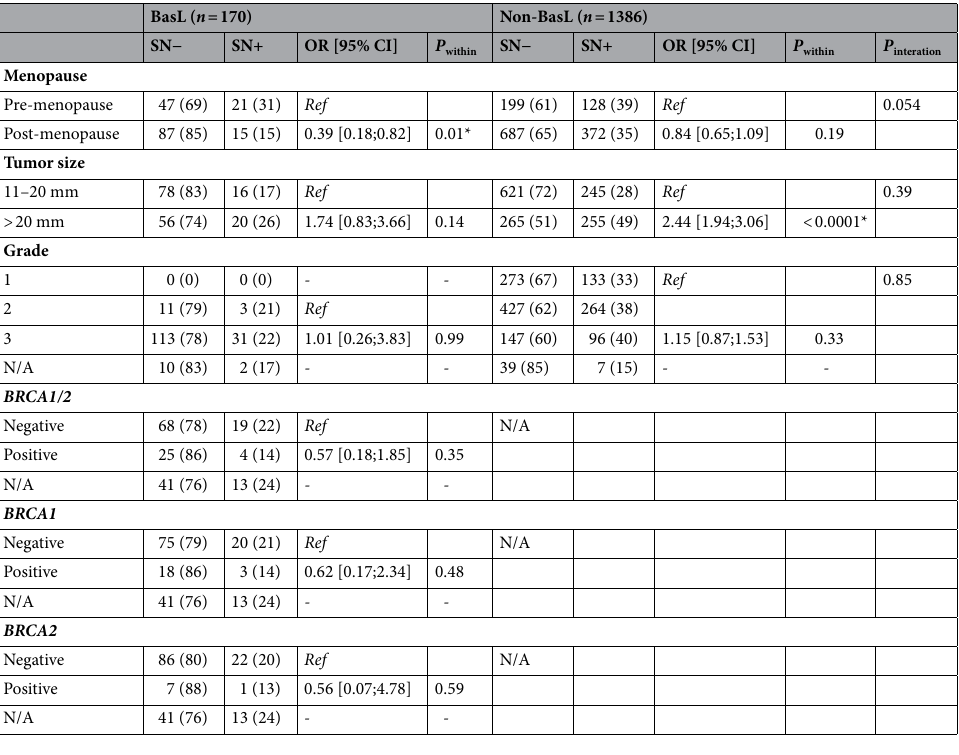
Table 3. Logistic regressions for sentinel node status. Multivariate regressions were used to analyze subtype (BasL or Non-BasL) together with each of menopausal state, tumor size, and tumor grade, respectively, and the odds ratio (OR) and 95% confidence interval (CI) within each subtype are reported. Wald tests were used to derive p values within each of the individual subtypes ( P within ) as well as for the interaction term ( P interaction ). Because only a limited number of non-BasL patients were screened for BRCA1/2 carrier status, univariate logistic regression was performed for these features within the BasL subtype. Row-wise percentages in